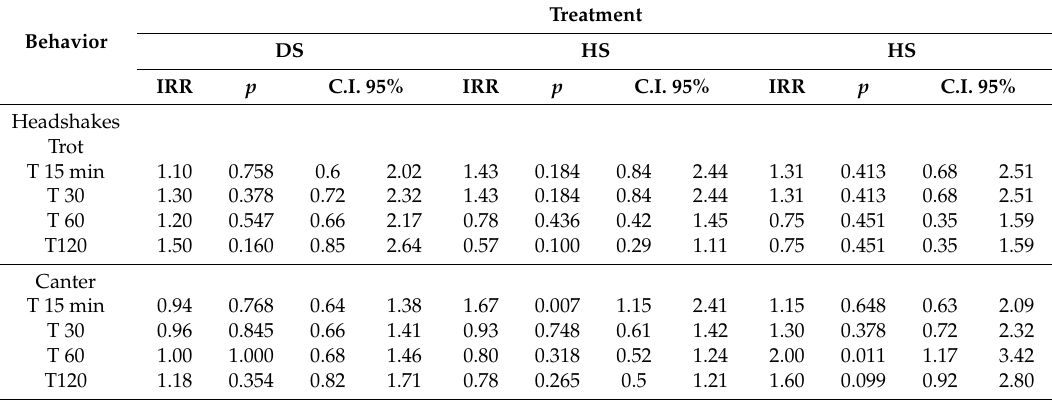
Table 3. Effect of treatment and time on incidence rate ratio (IRR) of median headshakes/minute at the trot and canter. IRR, p value and confidence intervals. p < 0.05 was considered significant.